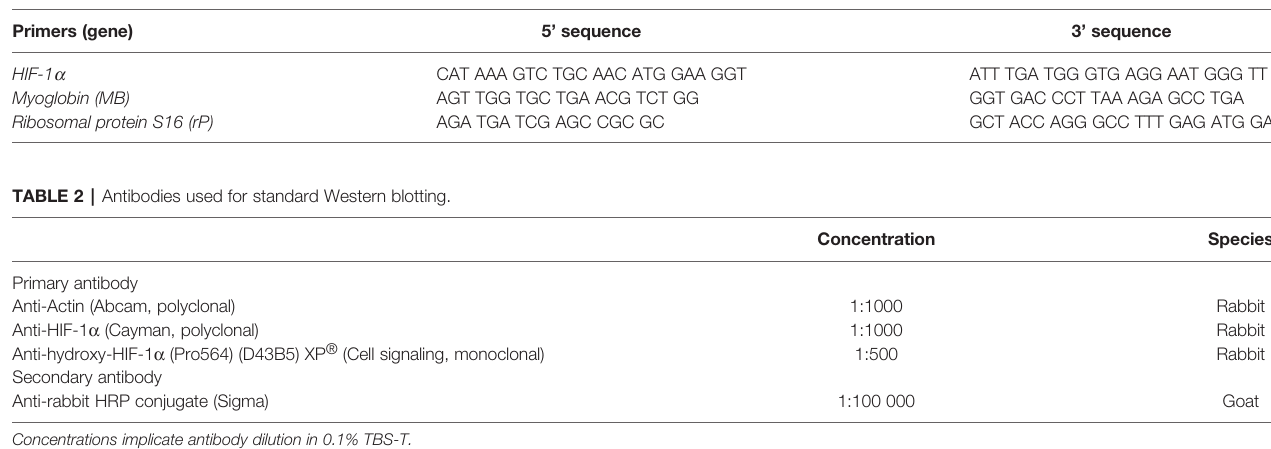
TABLE 1 | Primers for qPCR.